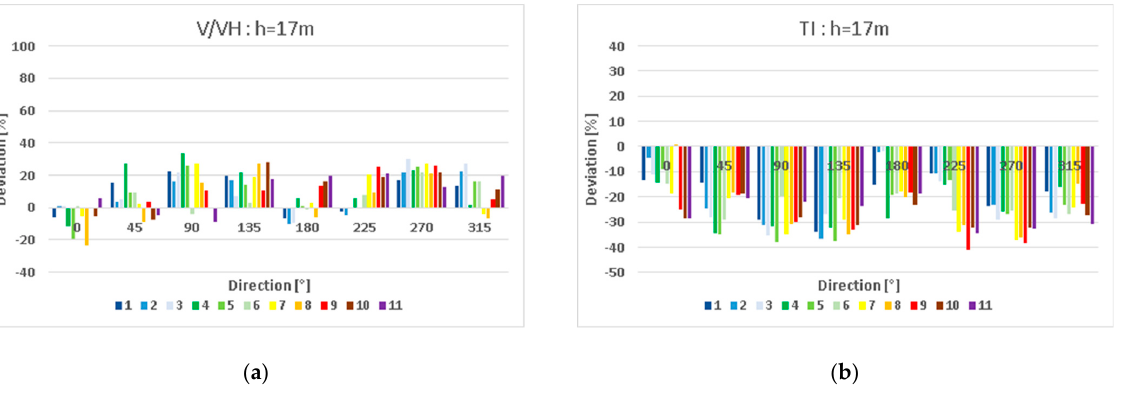
Figure 23. Mean absolute deviations of the wind ( a ) and turbulence intensity ( b ) per direction for the 11 probe validation points at height h = 17 m with WindSim.